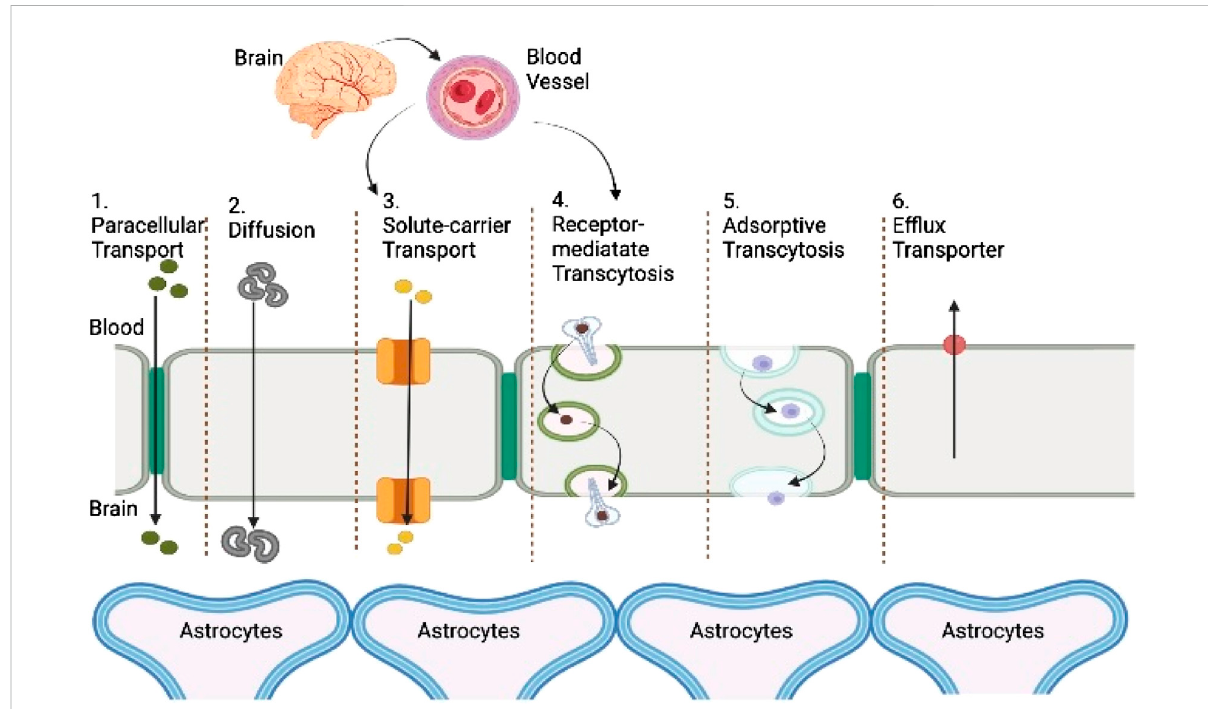
FIGURE 3 Representation of transport routes across the BBB. Passive transport: ionization of the medication, molecular weight, lipophilicity, and protein binding are the key elements that affect passive transfer through the BBB. When acidic substances are ionized, their transport through the BBB is